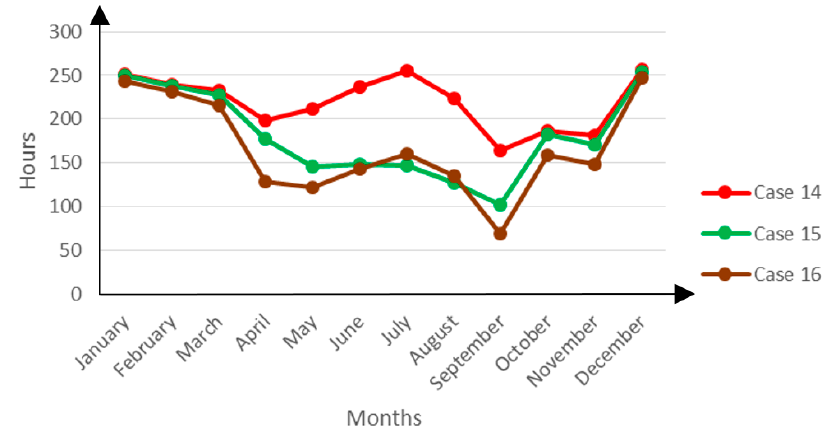
Figure 16. Discomfort hours for Cases 14, 15 and 16.